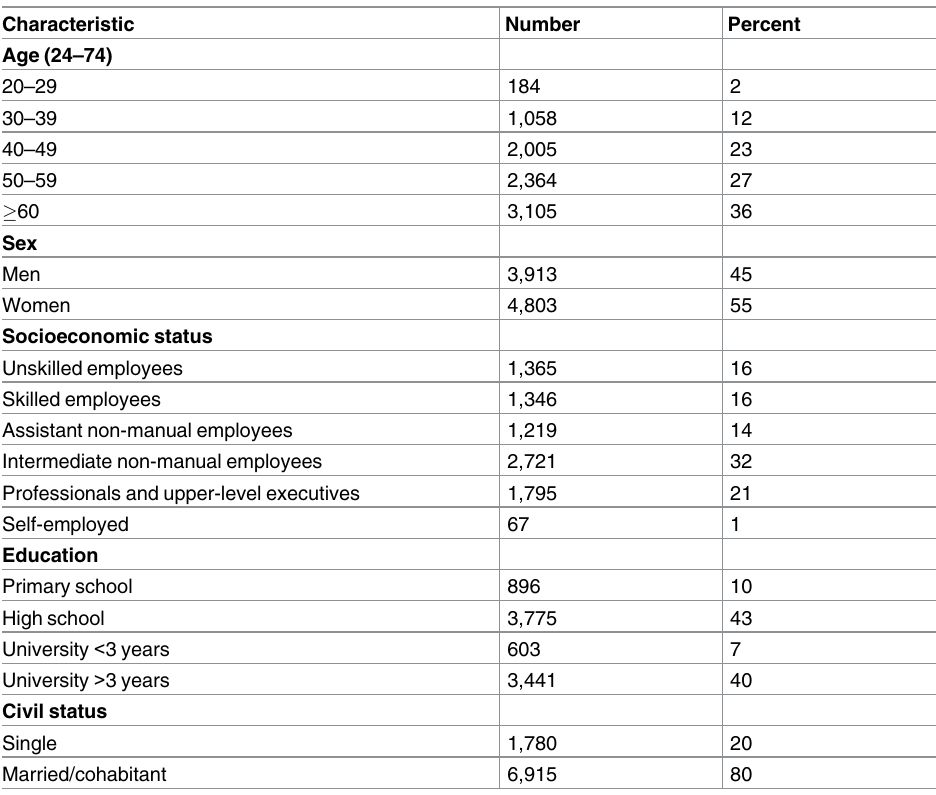
Table 1. Demographic characteristics of study